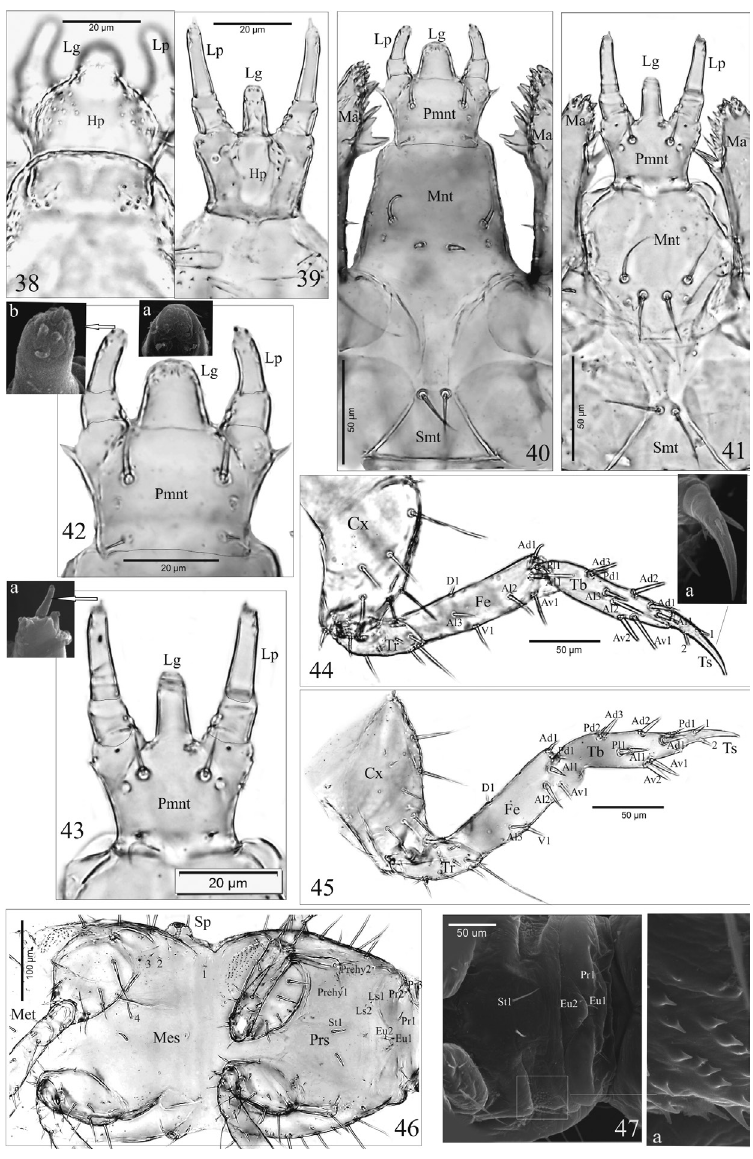
and labial palp ( 42b, 43a ), 44, 45 legs and tarsungulus ( 44a ), 46 pre- and mesosternum 47 anterior por- tion of presternum and microstructure ( 47a ). Abbreviations: 1, 2, 3, 4, setae of mesosternum; 1, 2, setae of tarsungulus; Ad, anterodorsal setae; Al, anterolateral setae; Av, anteroventral setae; Cx, coxa; D, dorsal setae; Eu, eusternum; Fe, femur; Hp, hypopharynx; Lg, ligula; Lp, labial palp; Ls, laterosternum; Ma, mala; Mes, mesosternum; Mnt, mentum; Pd, posterodorsal setae; Pl, posterolateral; Pmnt, prementum; Pr, prosternum; Prehy, prehypopleuron; Prs, presternum; Smt, submentum; Sp, spiracle; St, sternellum; Tb, tibia; Tr, tro- chanter; Ts, tarsungulus; V, ventral